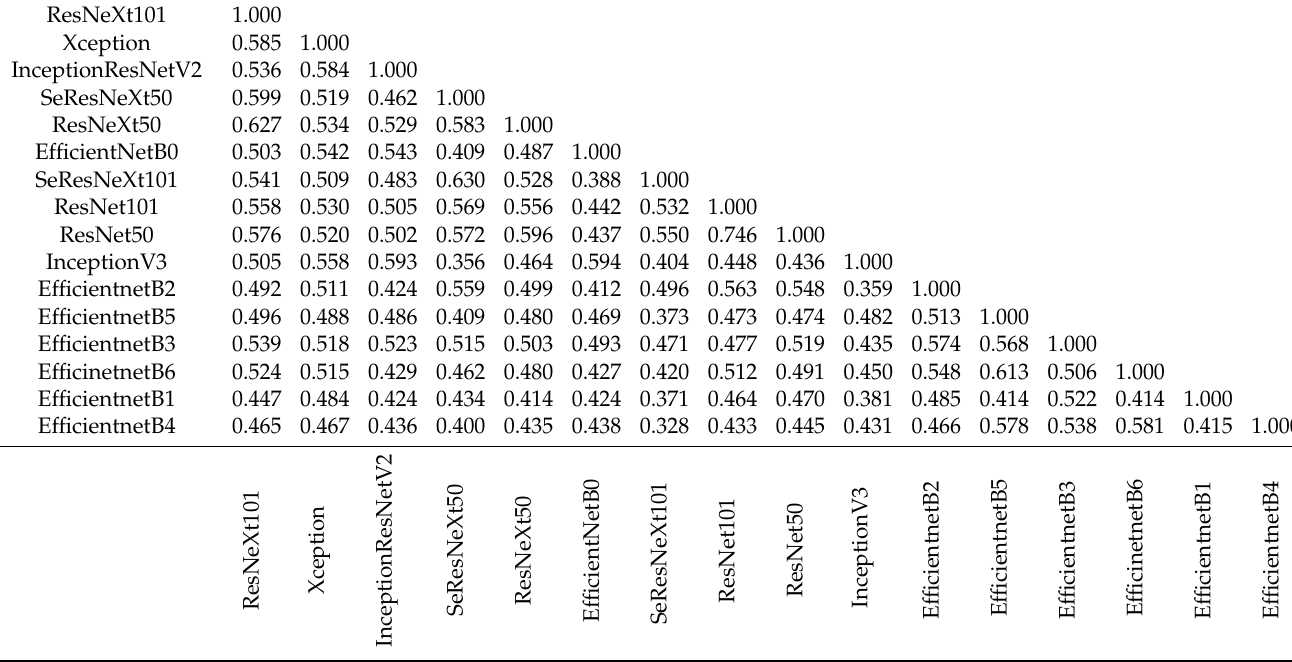
Table 6. Correlation matrix for each of the 16 CNN test